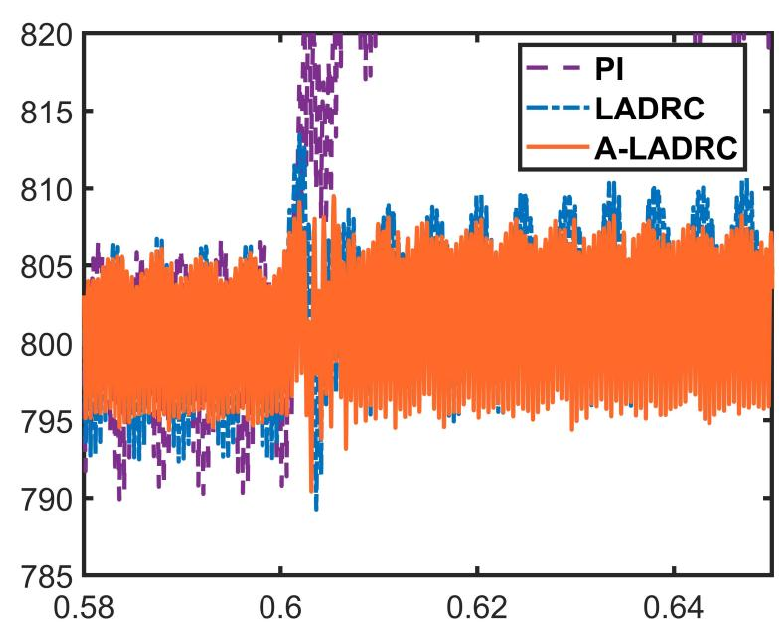
Figure 12. Partial enlarged drawing of DC bus voltage.